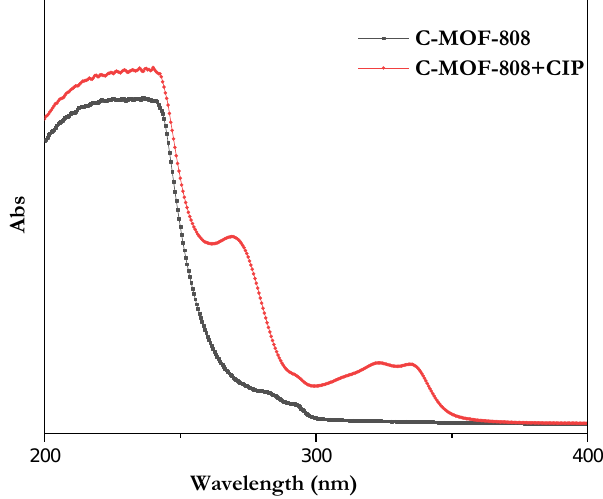
Figure 6. ( a ) Fluorescence spectra of receptor, CIP, and their mixture (  ex = 310 nm) and ( b ) real images of the aqueous solution of receptor with increasing concentration of CIP under UV-light.